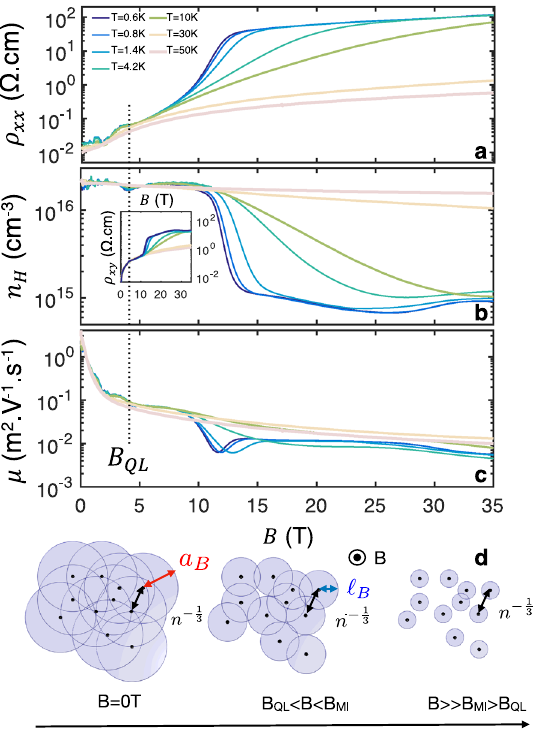
! ! ? B ) = ð a 2 a B ; k Þ 1 B B ; ?